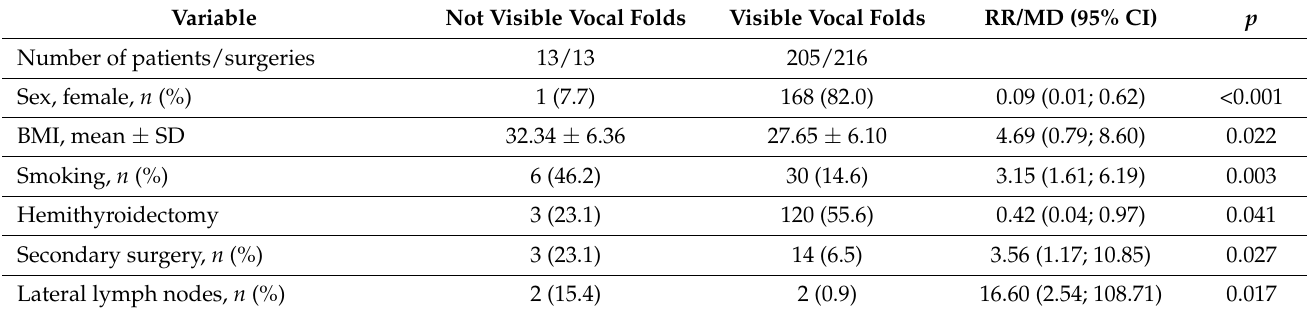
Table 6. Comparison of patients with visible and not visible vocal folds (before